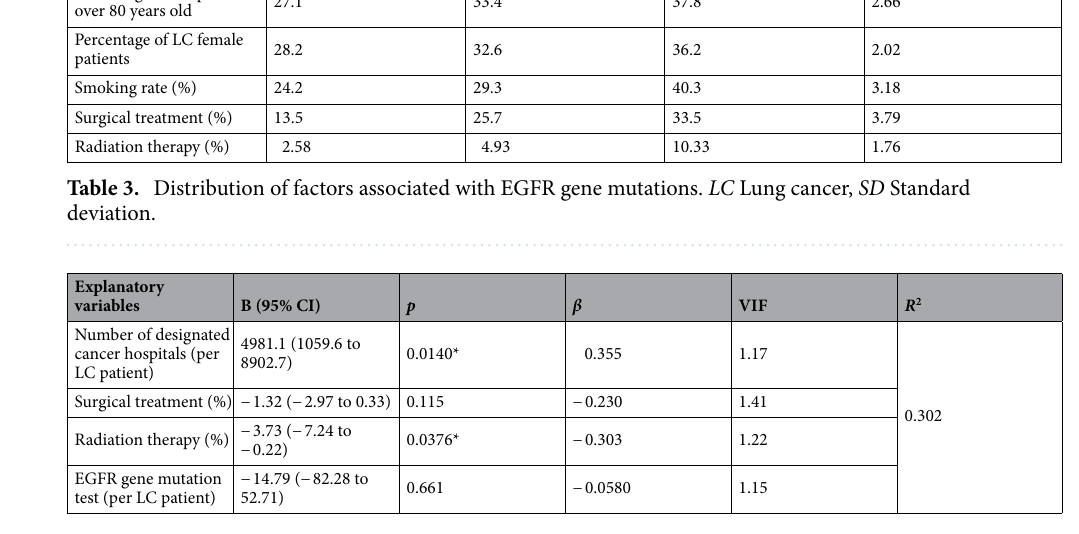
Table 4. Multiple regression analysis with SCR in 2018 as the objective variable. B Partial regression coefficient, β Standardized partial regression coefficient, VIF Variance inflation factor, R 2 Coefficient